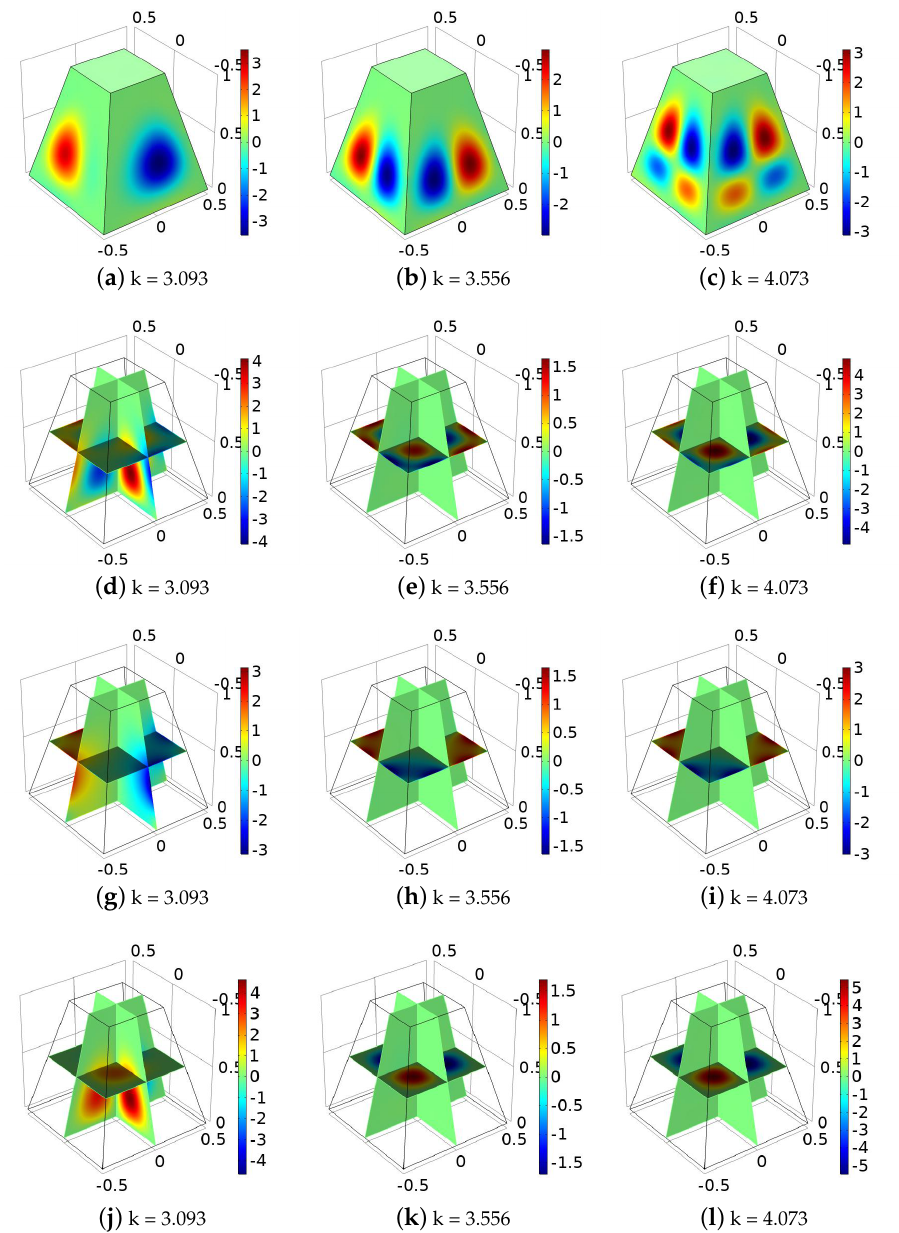
Figure 2. The magnitude of transmission eigenfunctions for a pyramid with different k